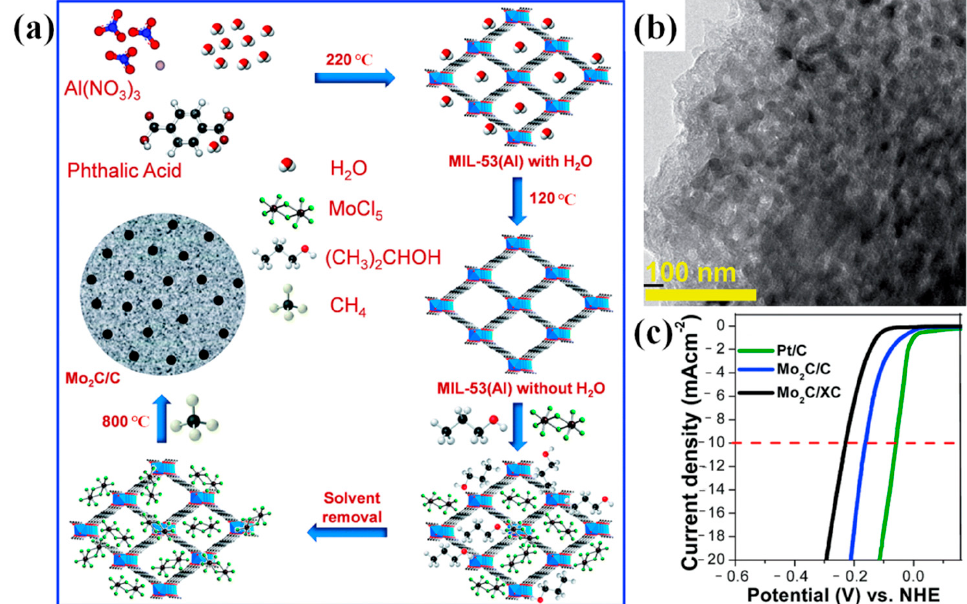
Figure 4. ( a ) Formation scheme of Mo 2 C/C electrocatalyst. ( b ) TEM of Mo 2 C/C. ( c ) Current–potential profiles of Pt/C, Mo 2 C/C and Mo 2 C/XC72. Reproduced with permission from [63]. Copyright 2016, The Royal Society of Chemistry.